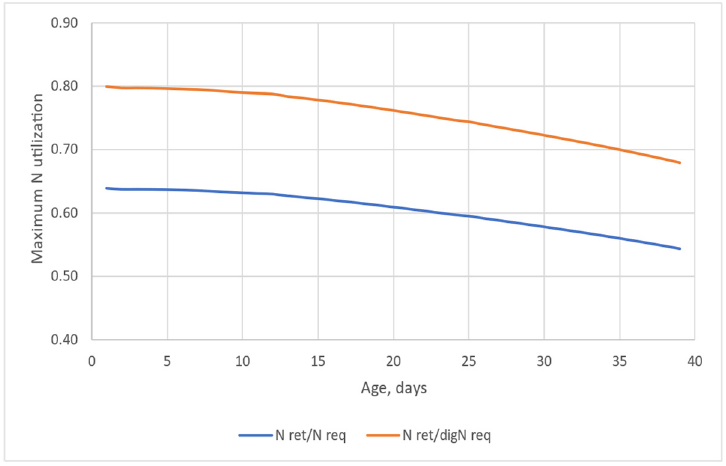
Figure 5. The theoretical maximum efficiency of N utilization defined as retained protein per protein requirement (N ret/N req; assuming 80% digestibility of dietary protein) or per digestible protein requirement (N ret/digN req) over the age.